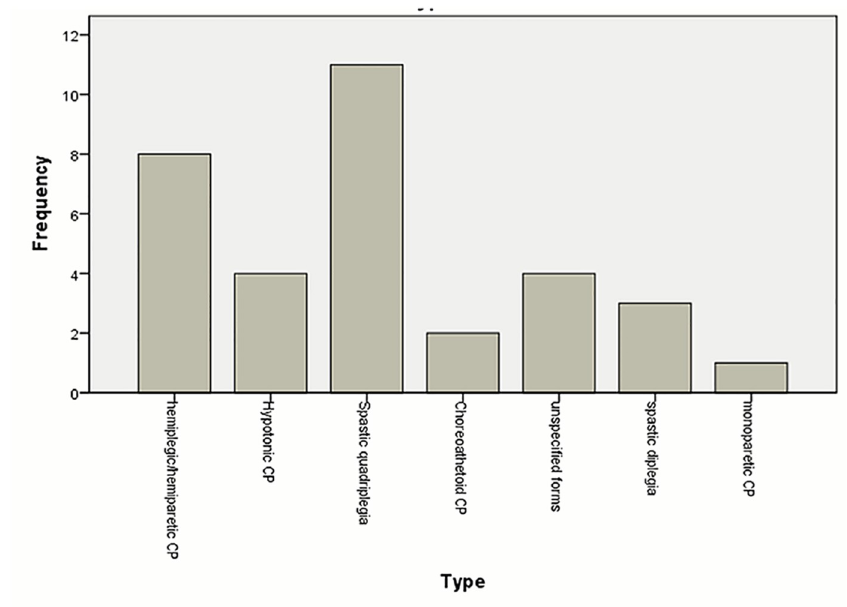
Fig 1. Types of cerebral palsy of patients who underwent neuroimaging at ACSH between January 2016 and August 2019. Majority of the patients had spastic quadriplegia (33.3%) followed by spastic hemiplegia/hemiparesis (24.2%) and hypotonic CP (12.1%). 9.1% of the patients had spastic diplegia while patients with choreoathetoid and monoparetic CP constituted 6.1% and 3% each. 12.1% of the patients had unspecified